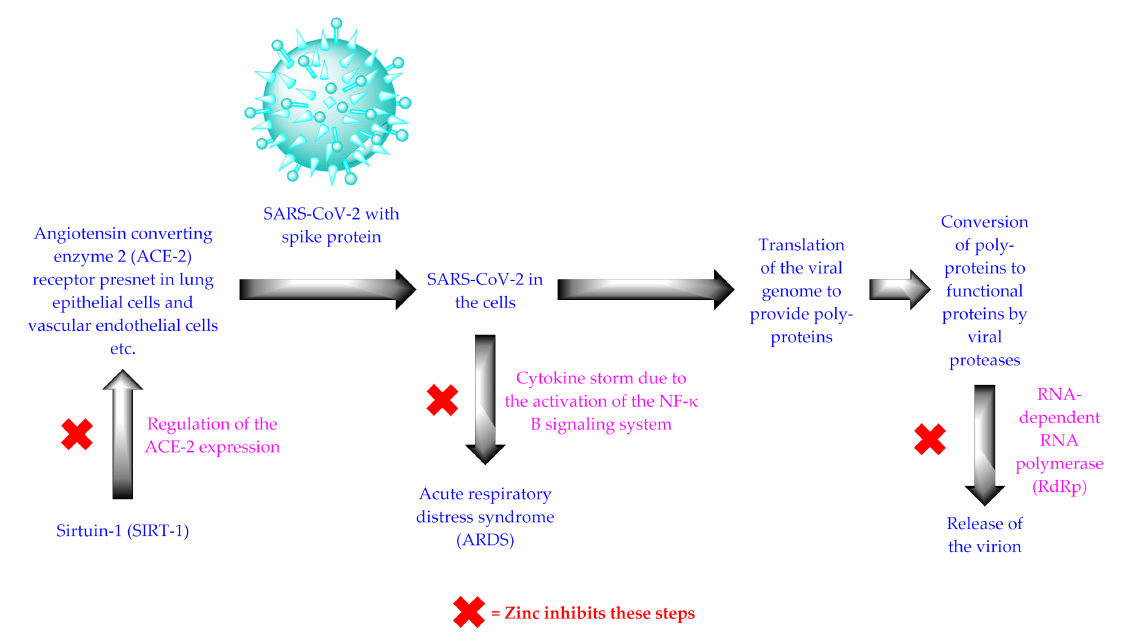
Figure 2. The life cycle of